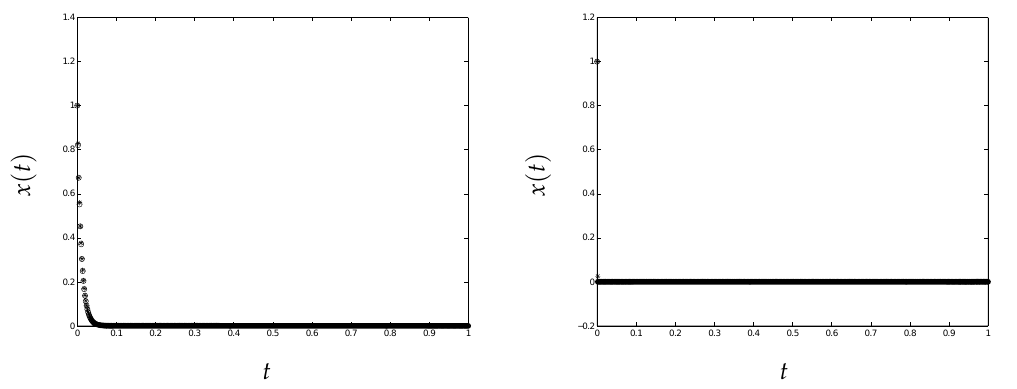
Figure 2. Variational approach, nonlinear test problem (“o”, original; “*”, approximation). ( left ) λ = − 100 and ( right ) λ = −